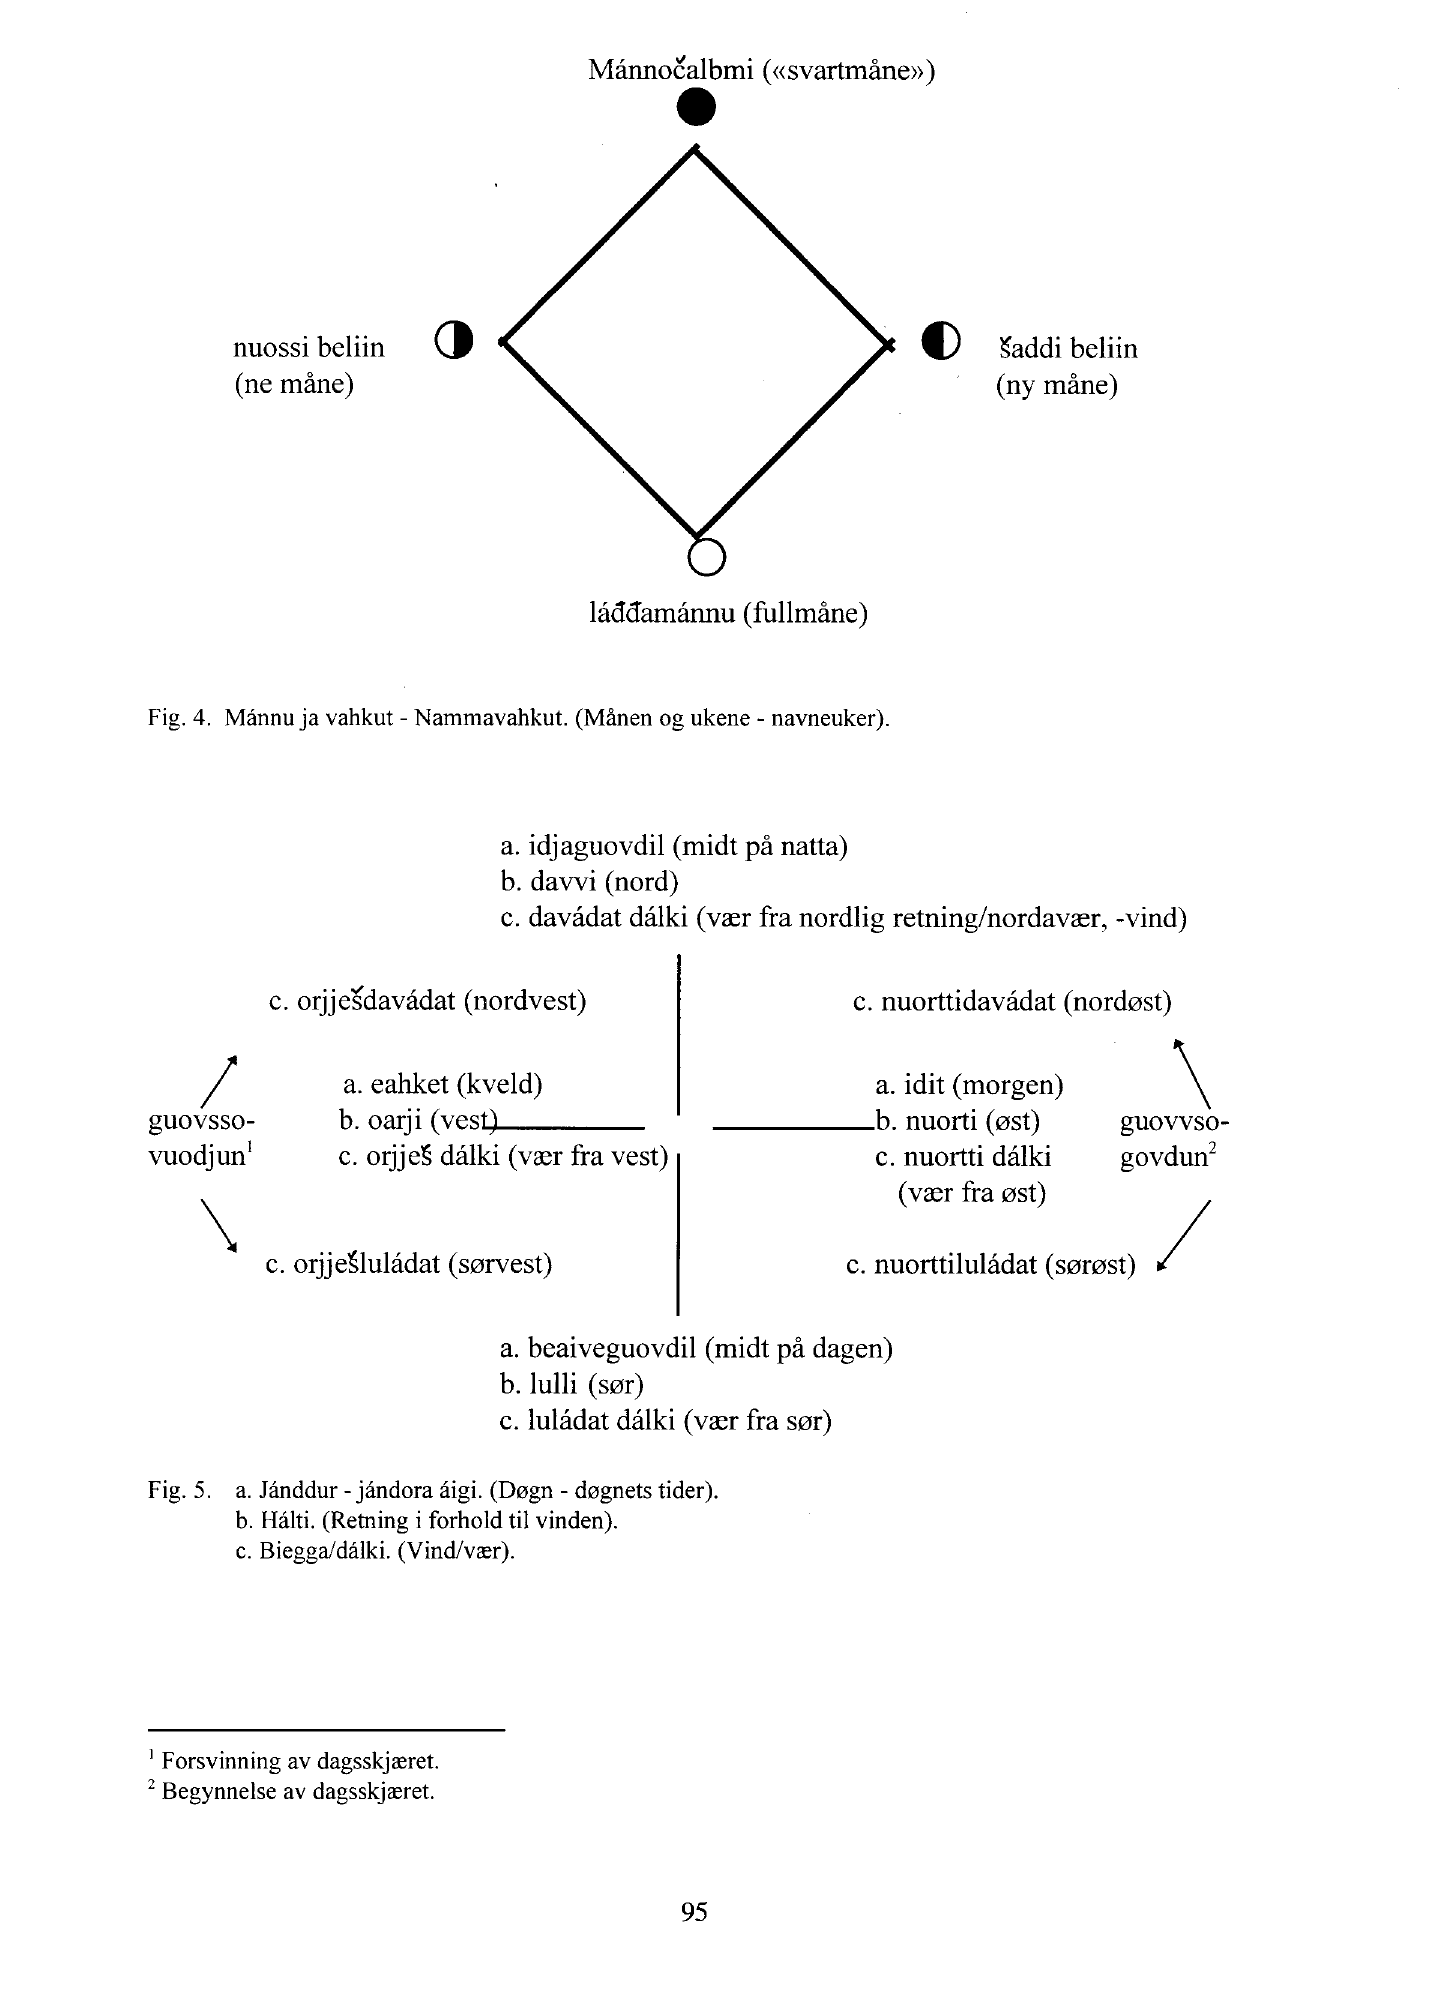
Fig. 4. Månnu ja vahkut - Nammavahkut. (Månen og ukene - navneuker).